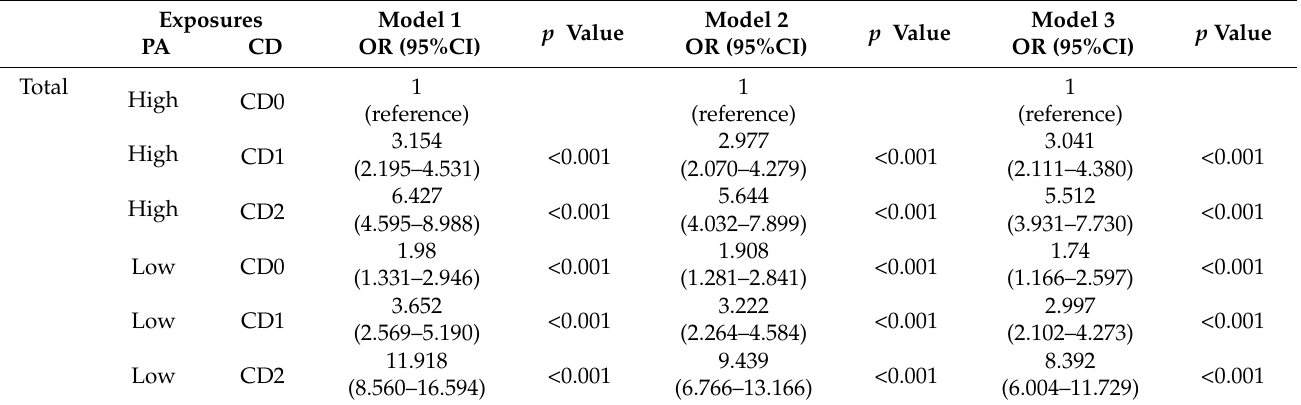
Table 3. Combined effects of physical activity and chronic diseases on